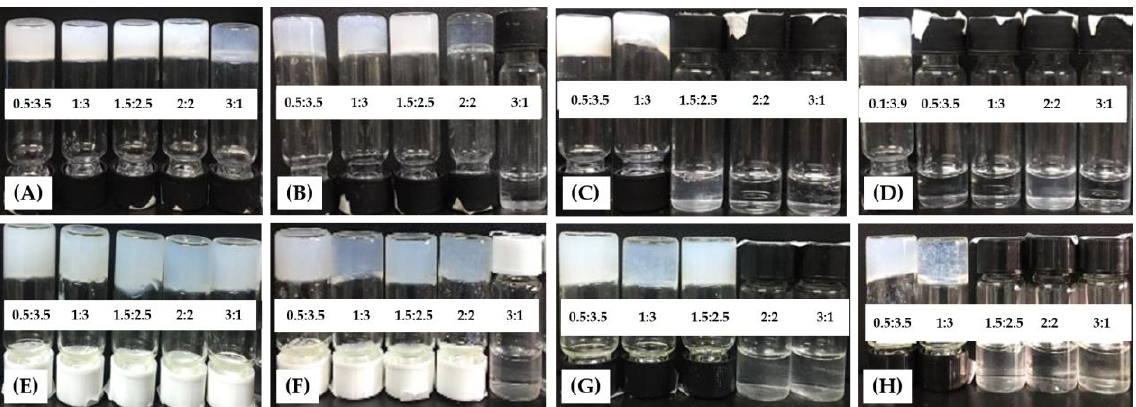
Figure 3. Photographs of vials showing gelation of gelators in alcohol – water mixtures with different volume ratios (v/v). ( A – D ): 2C12 - Lys-Na in methanol – H 2 O, ethanol – H 2 O, isopropanol – H 2 O, and t - butanol – H 2 O; ( E – H ): 2C14 - Lys-Na in methanol – H 2 O, ethanol – H 2 O, isopropanol – H 2 O, and t -buta- nol – H 2 O. Table 1. Gelation behaviors of 2C12-Lys-Na, 2C12-Lys-K, 2C14-Lys-Na, and 2C14-Lys-K in alcohol – water mixtures with different volume ratios ( v / v ).